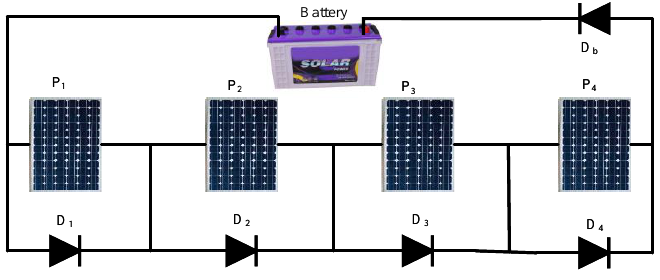
Figure 9 . Bypass and blocking diodes in PV module. Figure 9. Bypass and blocking diodes in PV